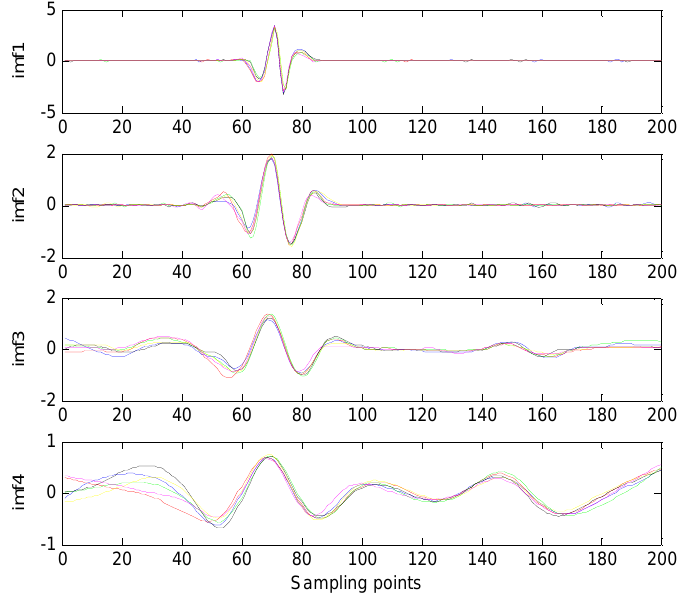
Figure 14. MIMFs from different sessions of record 302 m ECG